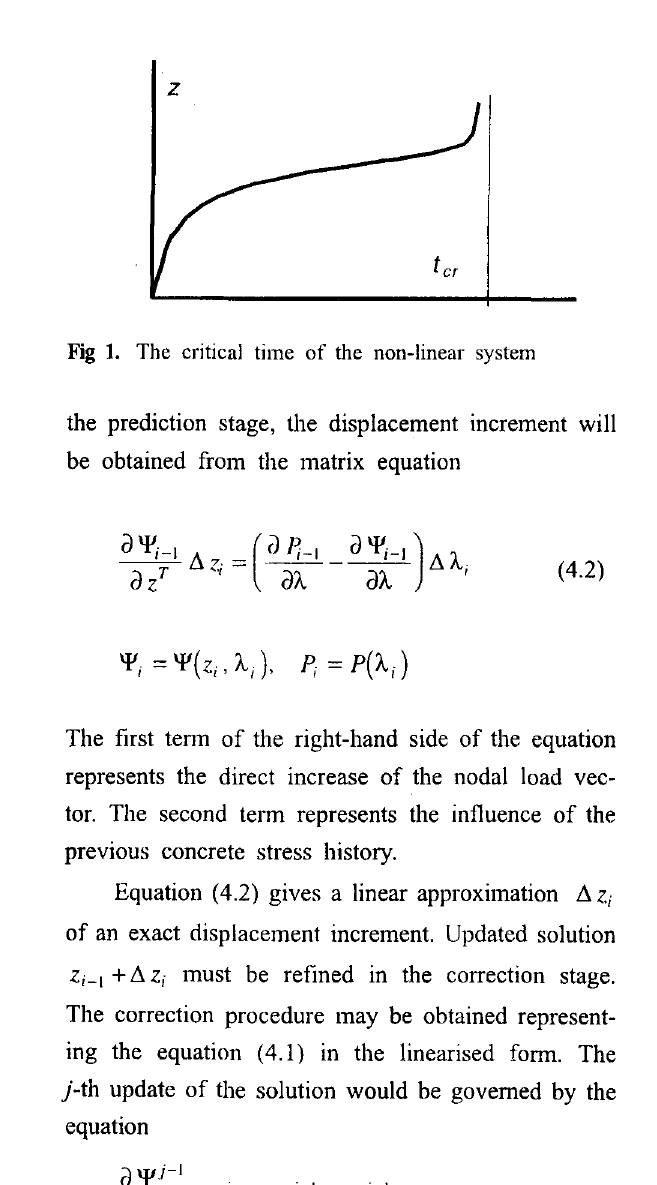
The first tenn of the right-hand side of the equation represents the direct increase of the nodal load vec tor. The second term represents the influence of the previous concrete stress